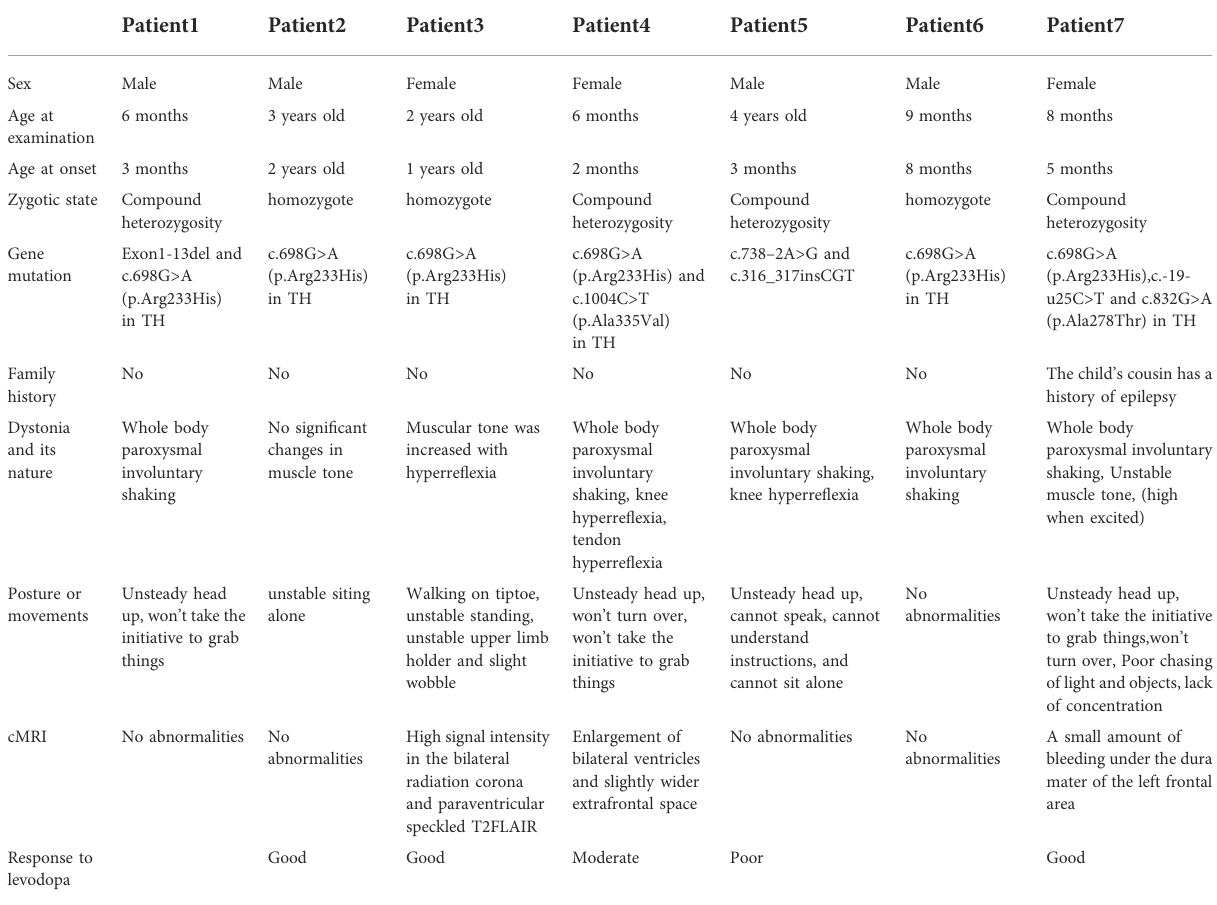
TABLE 1 Clinical features of the seven